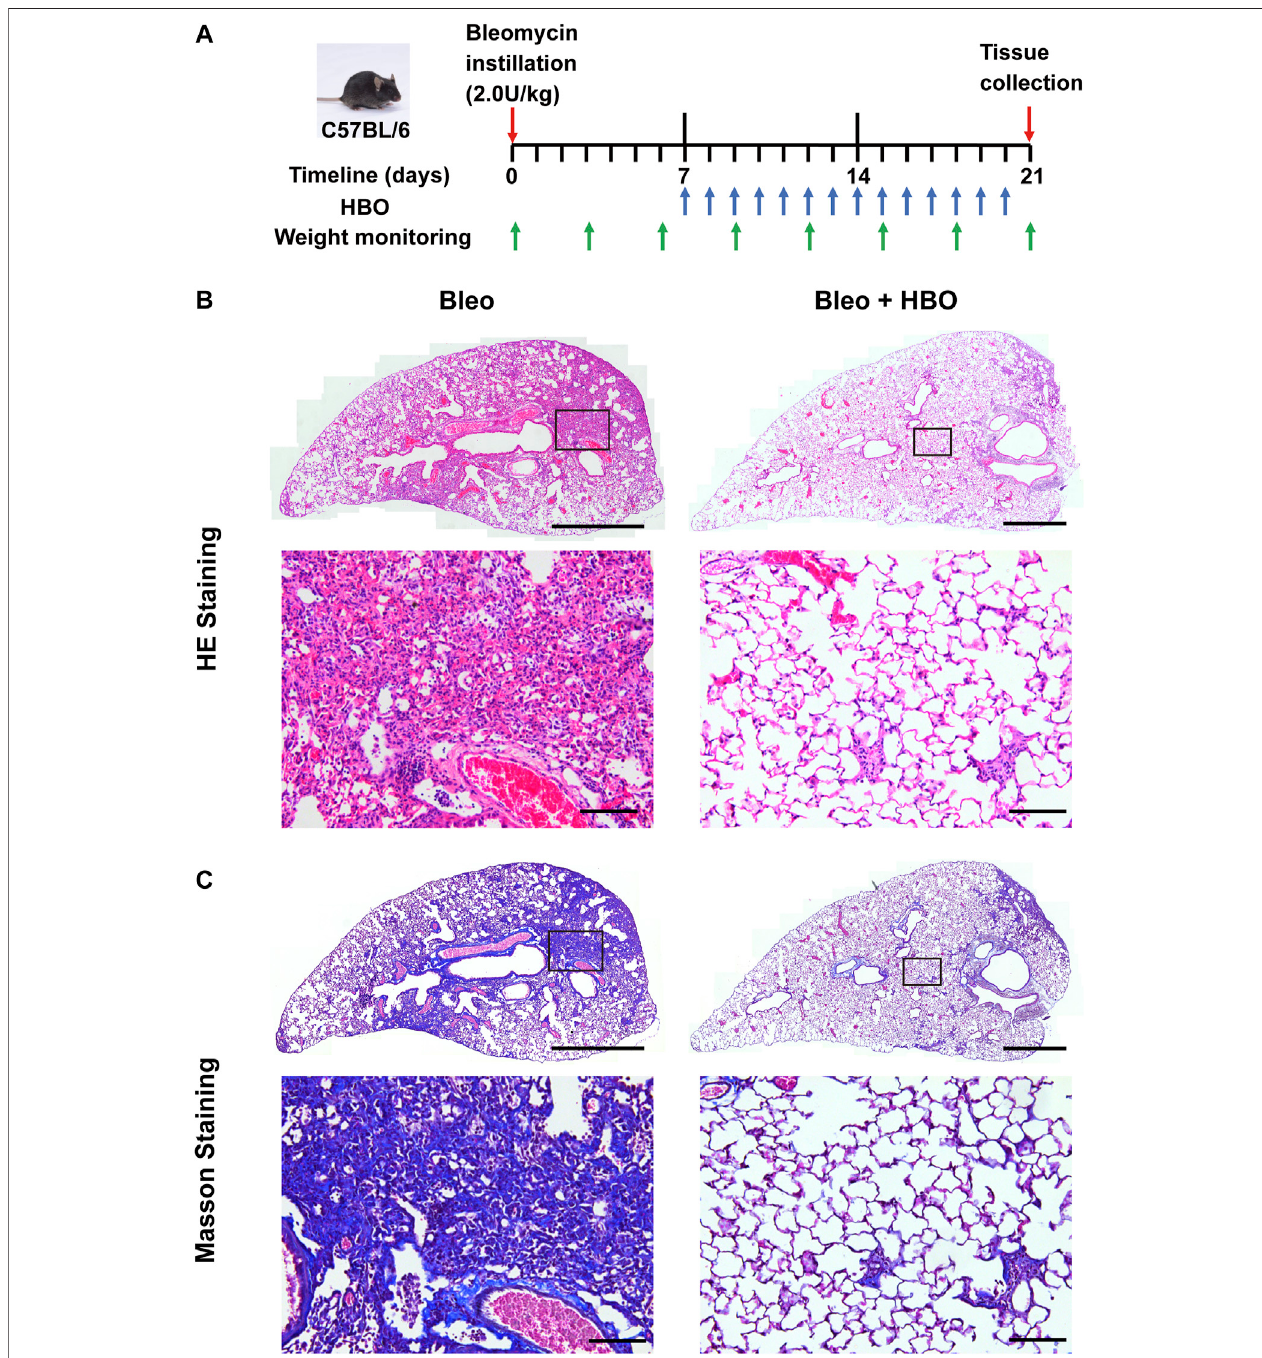
FIGURE 2 | Repetitive HBO treatments reduce the fi brotic area and collagen content in bleomycin-challenged mice lungs. (A) Schematic diagram of the experimental procedure (details in Methods ). (B,C) Lung tissues from bleomycin-challenged mice (Bleo) or bleomycin-challenged mice treated with repetitive HBO exposure(Bleo+HBO)werestainedwiththeH/E (B) orMasson ’ strichromestain[ (C) ,collagenshowninblue].In (B,C) ,toppanelsshowthewholeleftlunglobes(scale bar: 1 mm) with higher-magni fi cation images in bottom panels (scale bar: 100 μ m).